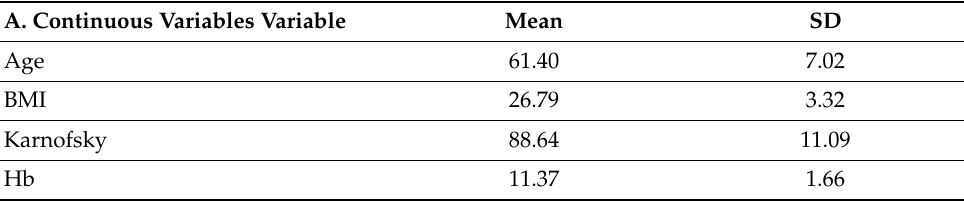
Table 3. Study characteristics of multiple myeloma